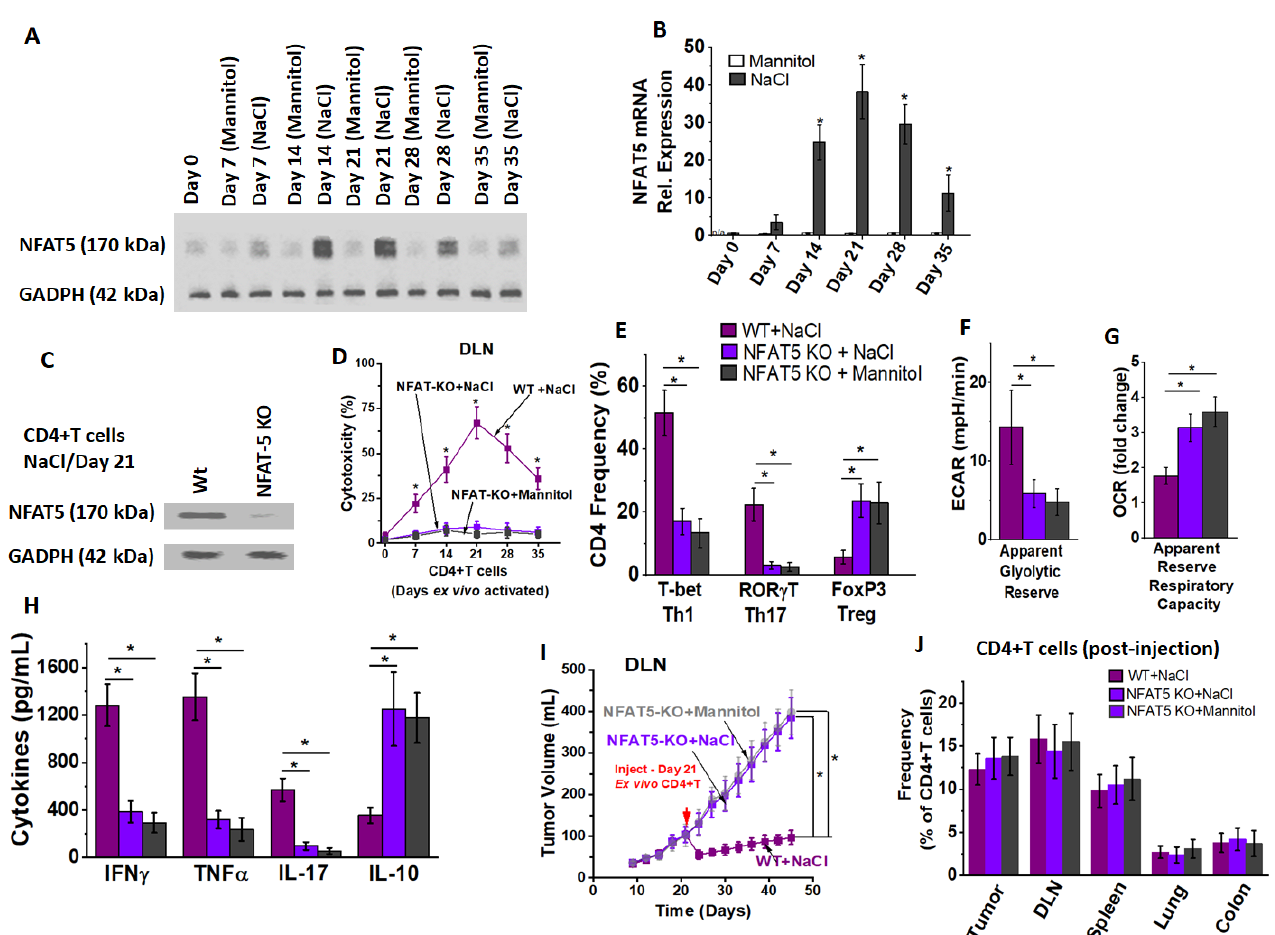
Figure 7. Critical role of NFAT5 in high salt-mediated effector responses. ( A , B ) NFAT5 expression analysis in CD4+T cells obtained from DLNs following high salt and equimolar mannitol treatment by Western blot ( A ) and qRT-PCR ( B ). NFAT5 expression analysis in CD4-specific NFAT5 knock out mice. CD4+T cells were obtained from the day 21 DLNs of the tumor bearing CD4+NFAT5-KO mice post-injection of Py230 breast cancer cells followed by three high salt stimulation cycles mentioned above (ex vivo day 21). ( C ) NFAT5 expression at the end of three ex vivo high salt stimulation cycles in day 21 DLN CD4+T cells obtained from wildtype (Wt) and CD4+NFAT5-KO (NFAT-5 KO) mice. ( D ) Cytotoxicity of CD4+T cells obtained from DLNs of CD4+NFAT5-KO tumor model following high salt treatment (purple square), DLNs of CD4+NFAT5-KO tumor model following equimolar mannitol treatment (grey square) and DLNs from wild-type following similar high salt treatment (magenta squares) tested on Py230 breast cancer cells at effector-to-target (E:T) ratio of 20:1. ( E – H ) Th-phenotypic frequencies ( E ), apparent glycolytic reserve ( F ), apparent reserve respiratory capacity ( G ) and cytokine expression ( H ) on the ex vivo high salt expanded CD4+T cells obtained from CD4+NFAT5-KO mice (purple square). The mannitol expanded CD4+T cells obtained from CD4+NFAT5-KO mice (grey squares) and high salt expanded CD4+T cells obtained from wild-type (magenta squares) were also shown. All cellular data were obtained from 5 independent measurements and presented as mean ± SEM; (*) p < 0.05. ( I ) Changes in tumor volume following injection on day 21 into Py230 orthotopic syngeneic tumors in wild type with CD4+T cells obtained from DLNs of CD4+NFAT5-KO tumor model following high salt treatment (purple square), DLNs of CD4+NFAT5-KO tumor model following equimolar mannitol treatment (grey square) or from wild-type following similar high salt treatment (magenta squares). ( J ) Tumor and organ localization of injected CTV labelled CD4+T cells (ex vivo expanded) obtained from DLNs of CD4+NFAT5-KO tumor model following high salt treatment (purple), DLNs of CD4+NFAT5-KO tumor model following equimolar mannitol treatment (grey) or from wild-type following similar high salt treatment (magenta). Data presented and percentage of CD4+T cells in the tumor, DLNs, spleen lung and colon to the total number of resident CD4+T cells in that respective tumor or organ. Data represented as mean ± SEM with n = 6 mice in each cohort, p <